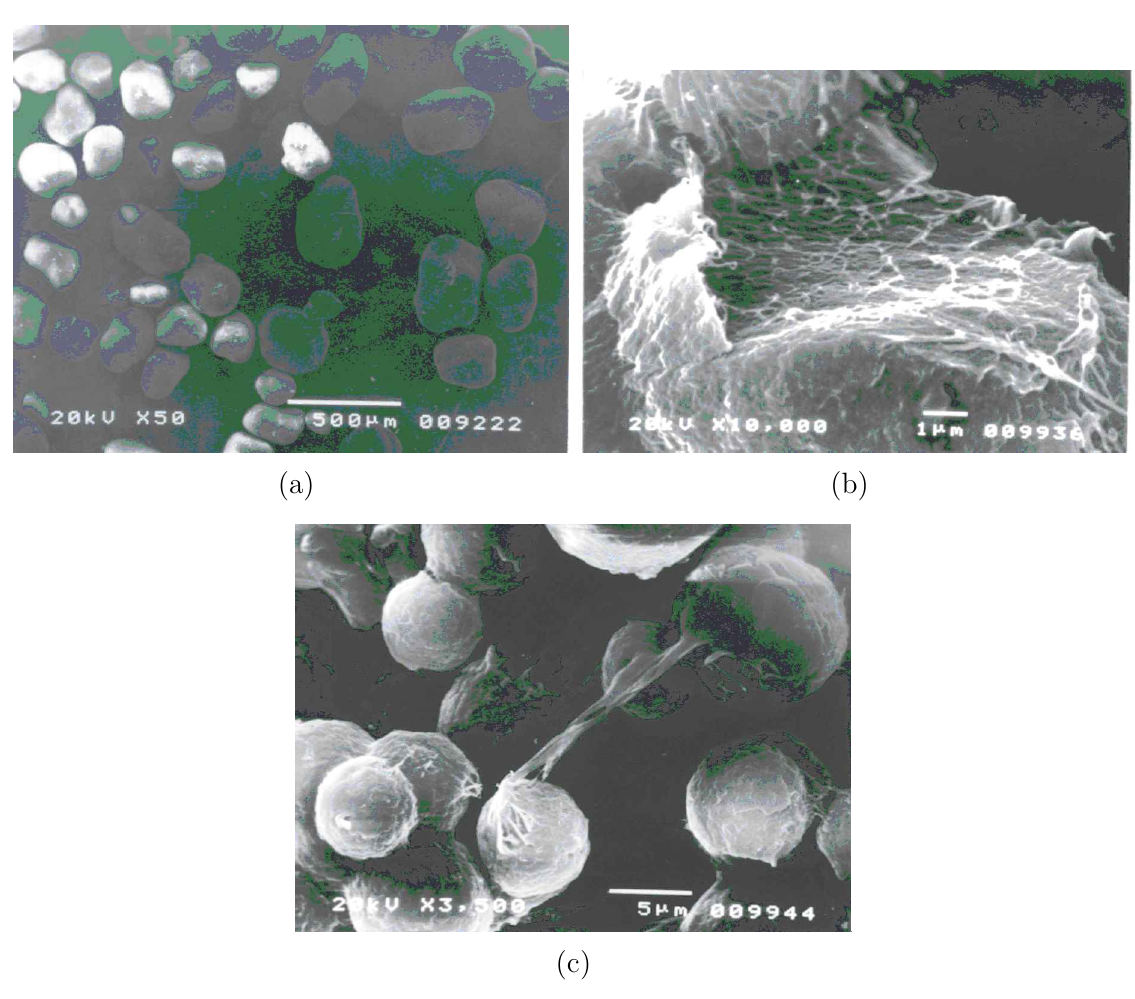
Fig. 1 Scanning electron micrographs of initial PP (a) and the particles surface undergone plastic deformation